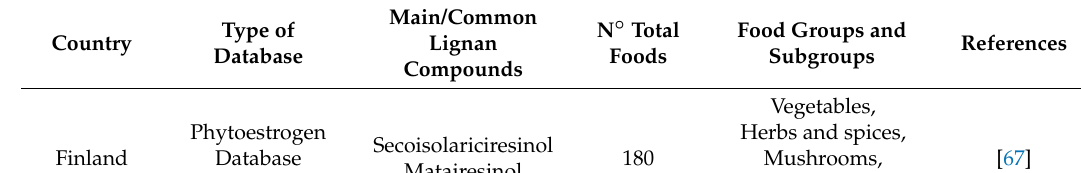
Table 1. National databases of